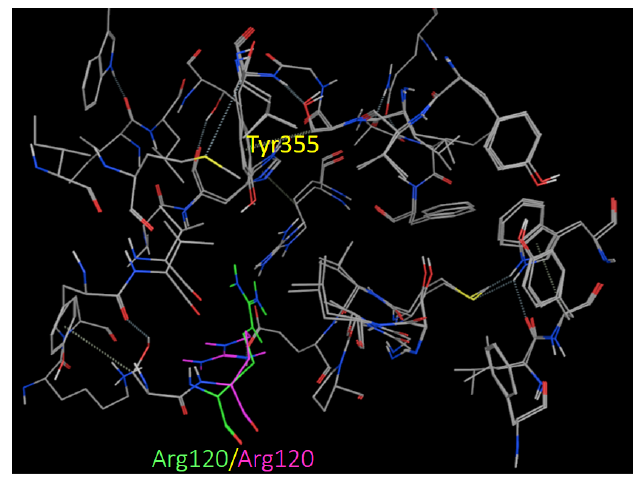
Figure 4. Superimposed COX-2 binding sites from the two co-crystals PDB 3LN1 and PDB 6BL3 showing Arg120 conformation alteration.